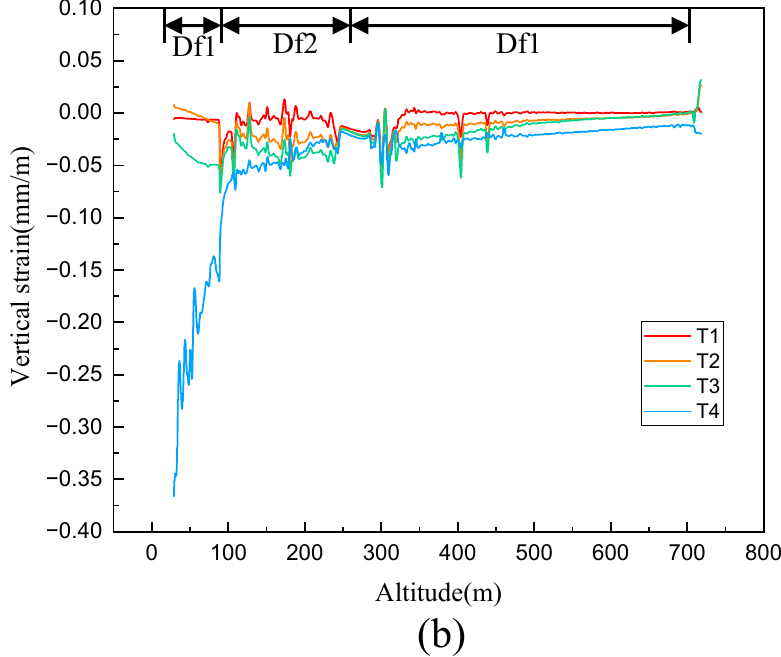
Figure 13. Horizontal and vertical strains of Df shafts ( a ) Horizontal strain of the Df shafts; ( b ) Vertical strain of the Df shafts. Table 3. Critical strain of shafts specified in the code for design of metal mine in China. Horizontal (Vertical) Strain Inclination Curvature Critical strain 2 × 10 −